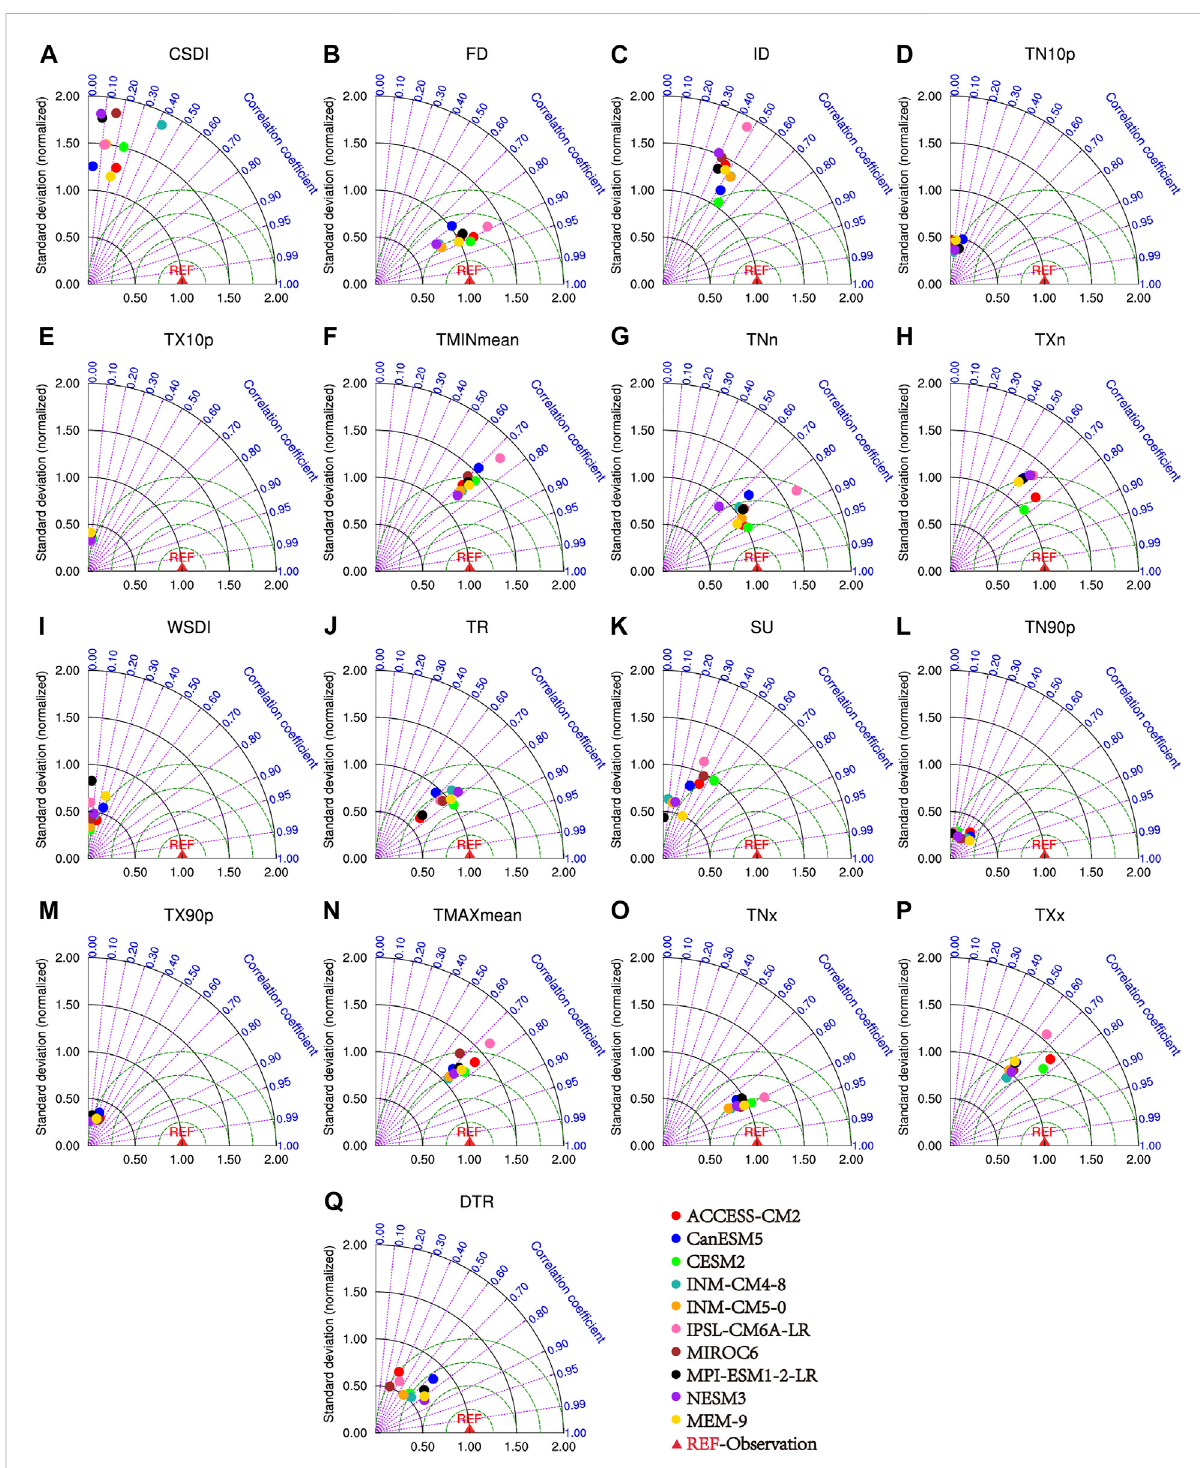
FIGURE 2 Taylordiagramof9CMIP6modelsandMEM-9simulated fi eldsrelativetoobserved fi eldsfor17ETIsinthehistoricalbaseperiods (A) CSDI (B)